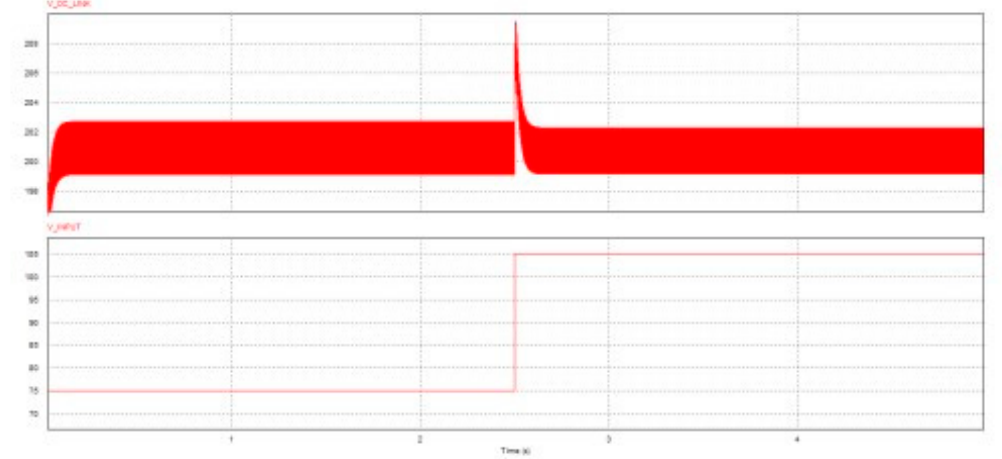
Figure 5. Voltage on the DC Bus and input voltage to the converter in Island mode.